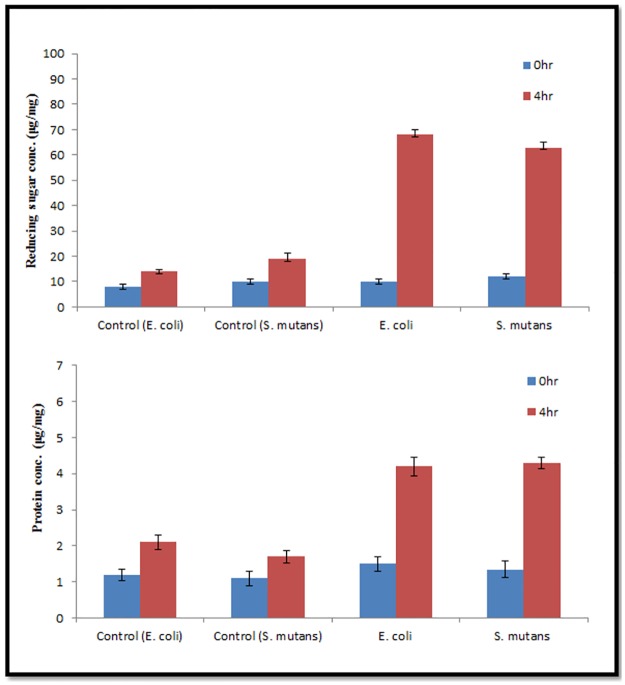
Leakage of reducing sugars (a) and proteins (b) from E. coli and S. mutans cells treated with AgNPs (Concentration of AgNPs is in μg ml-1).Error bars represent standard deviations of triplicate incubations.